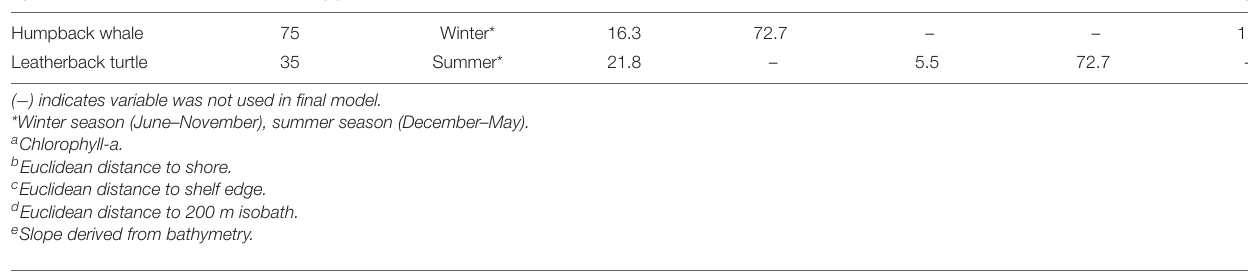
TABLE 5 | Selected environmental variables after pruning the covariates ( Supplementary Material ) as well as permutation importance used for final species distribution models. Species